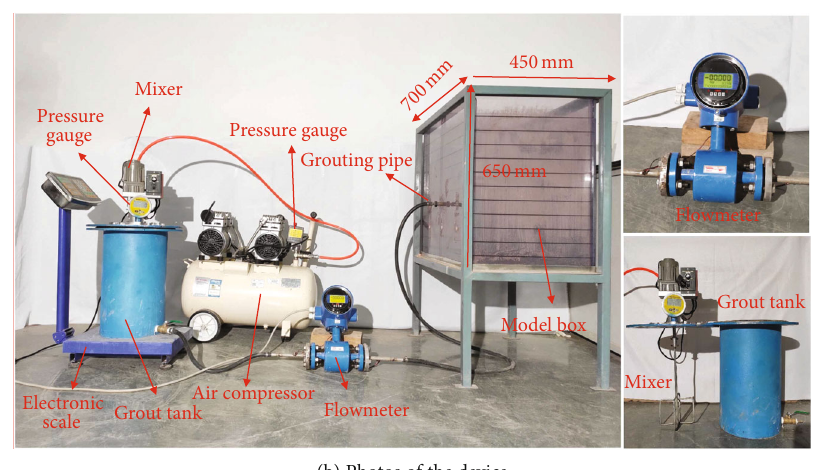
Figure 3: Test set-up.